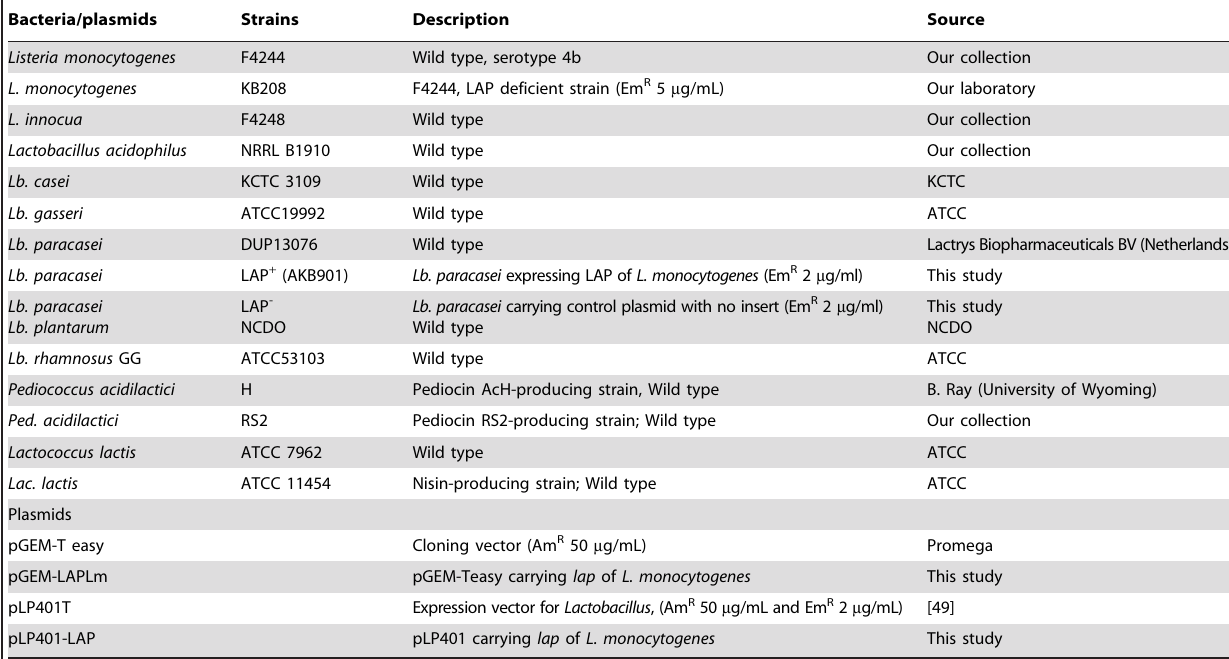
Table 1. Bacterial strains and plasmids.